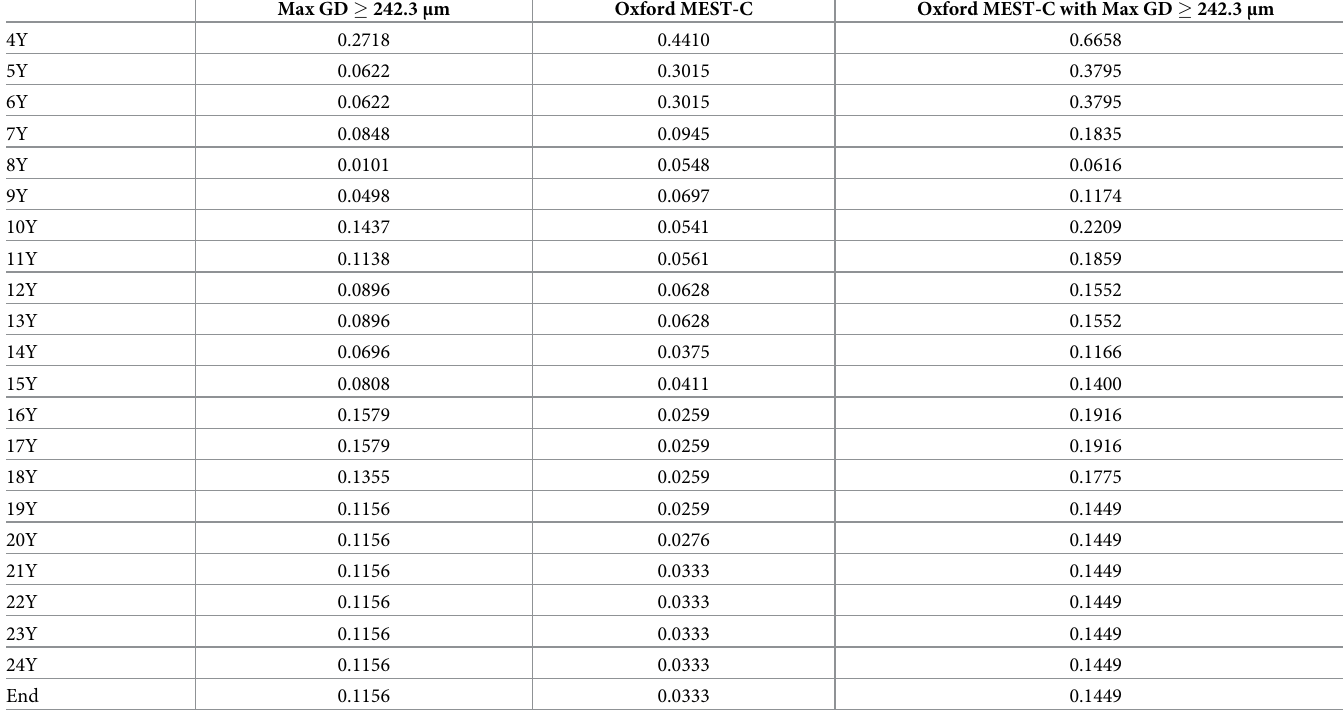
Table 3. Time series changes in pseudo-R 2 regarding prognostic efficacy for renal outcome: Max GD and Oxford MEST-C